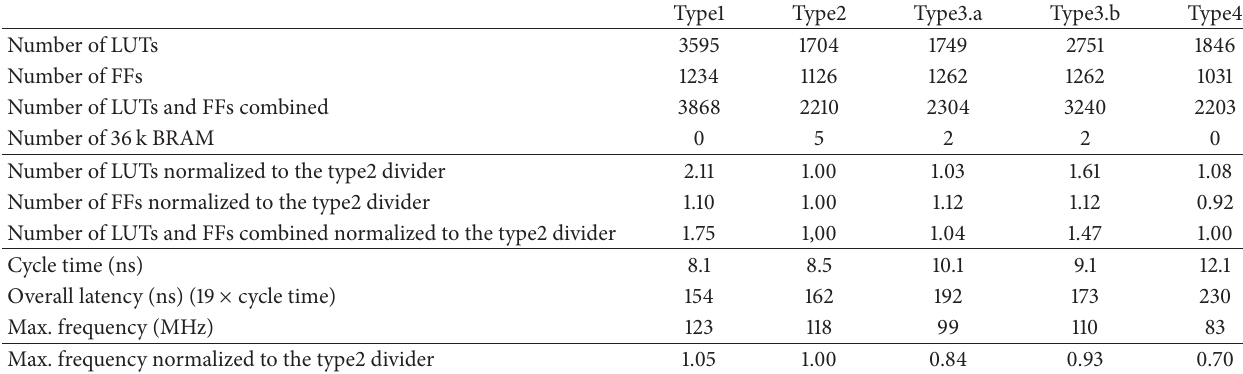
Table 4: Results for normalized decimal fixed-point dividers, 𝑝 = 16 + 1 .